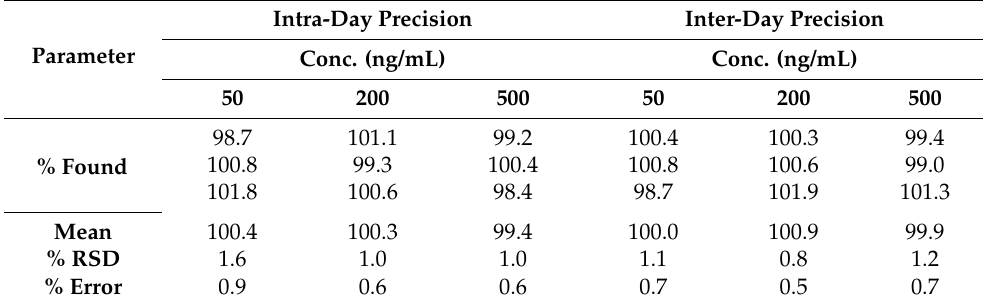
Table 3. Results of the accuracy and precision study of the proposed spectrofluorimetric method for NFZ